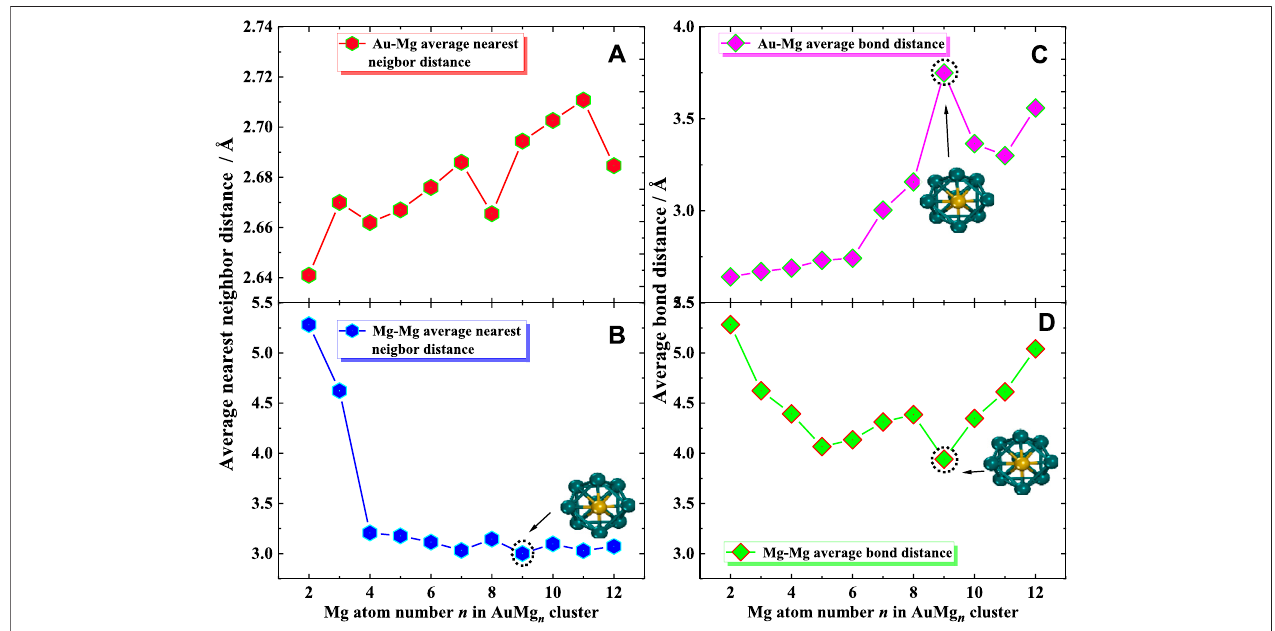
FIGURE 10 | (A,B) Average nearest neighbor distance for Au-Mg and Mg-Mg, (C,D) Average bond distance for Au-Mg and Mg-Mg.